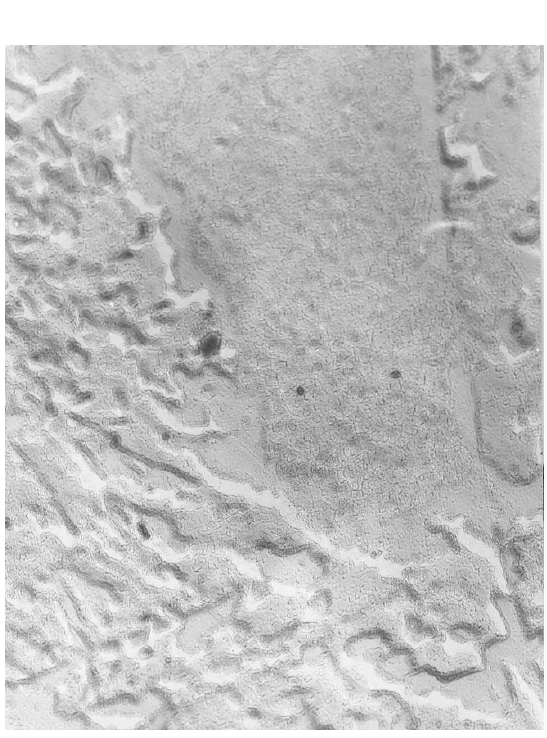
Figure 3. Structure of lath bainite ( × 45 000).